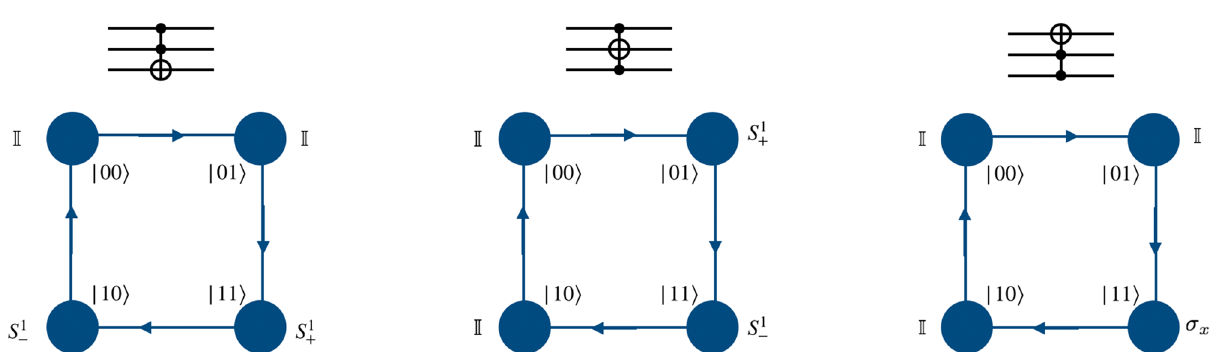
Figure 8. Schematic illustration of the Toffoli gate on a three-qubit system using position dependent quantum walk